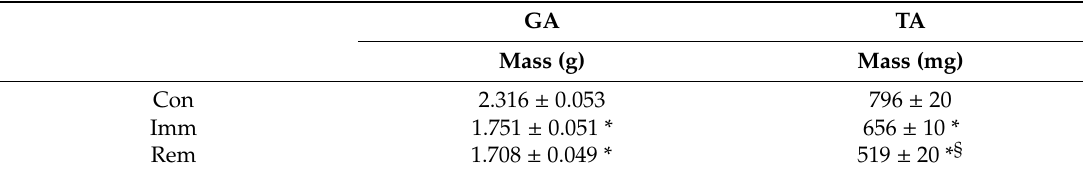
Table 1. GA and TA muscle mass.